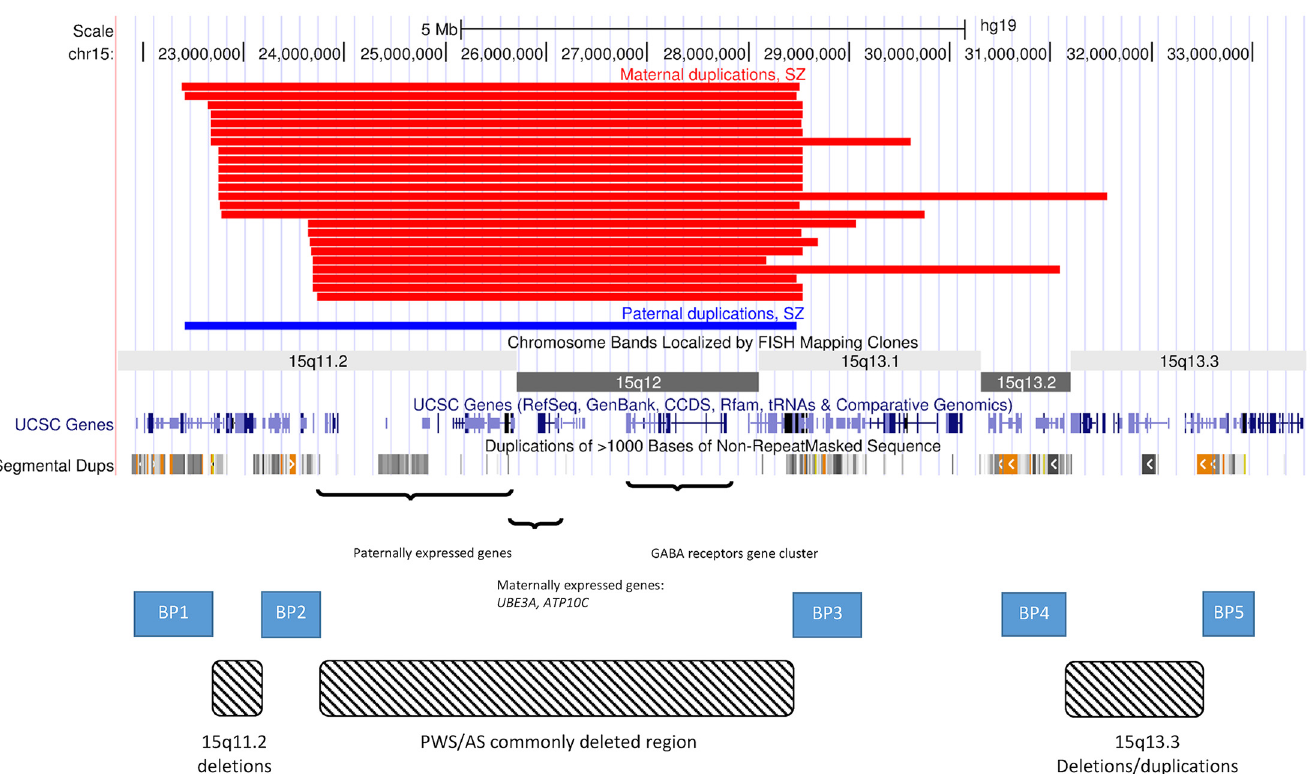
Fig 1. CNVs on chromosome 15. The image depicts the region on chromosome 15 that is affected by deletions and duplications caused by a number of low copy repeats. These form five recognised breakpoints (BPs) which cause the formation of deletions and duplications of different sizes. Several of them result in recognised syndromes: PWS/AS, 15q11.2 deletion and 15q13.3 deletion and duplication. The black bars at the top show the positions of the SZ/SZA probands in the current study (S1 Table). All four combinations of duplications between BP1 and BP4 are represented. They all intersect the regions of maternally and paternally expressed genes and the GABA receptors gene